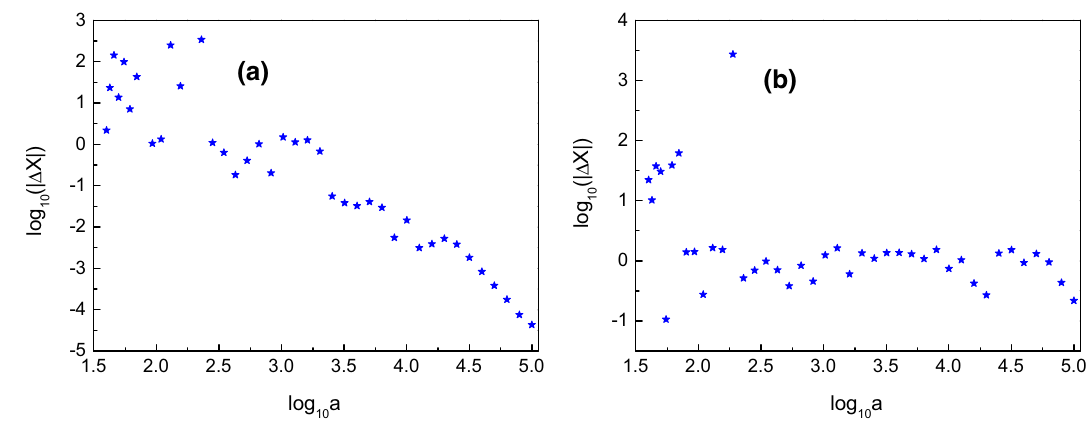
Fig. 11 Dependence of orbital errors | Δ X | on a between orbits in the truncated system (16)–(17) and those counterparts in the exact system (12) with the same initial values: a Orbit 1; b Orbit 3